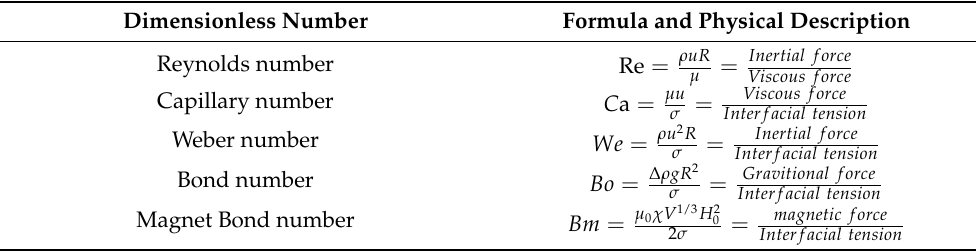
Table 1. Dimensionless number in magnetic droplet